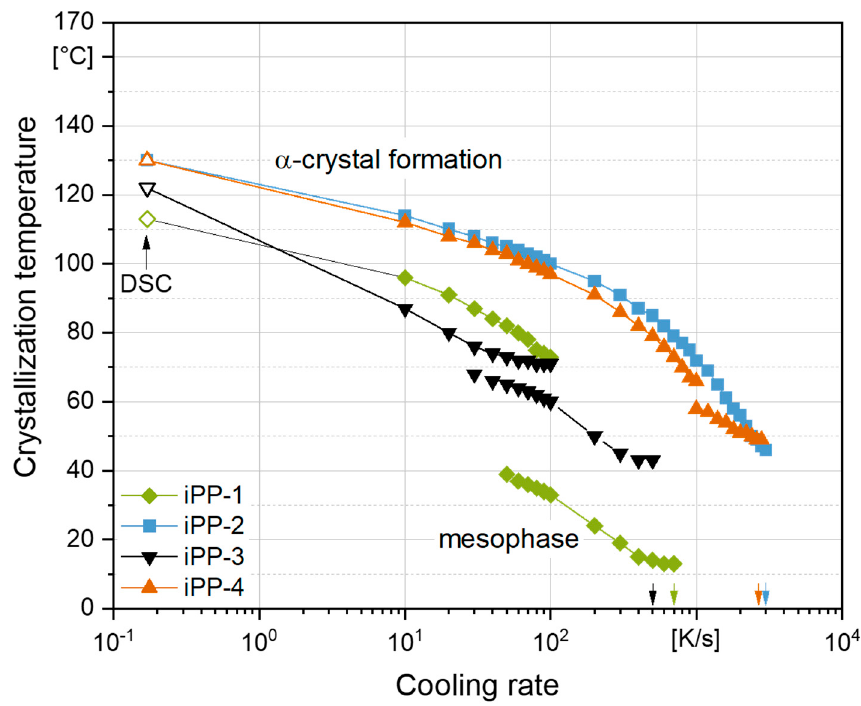
Figure 4. Crystallization temperature of the investigated iPP grades as function of the cooling rate.